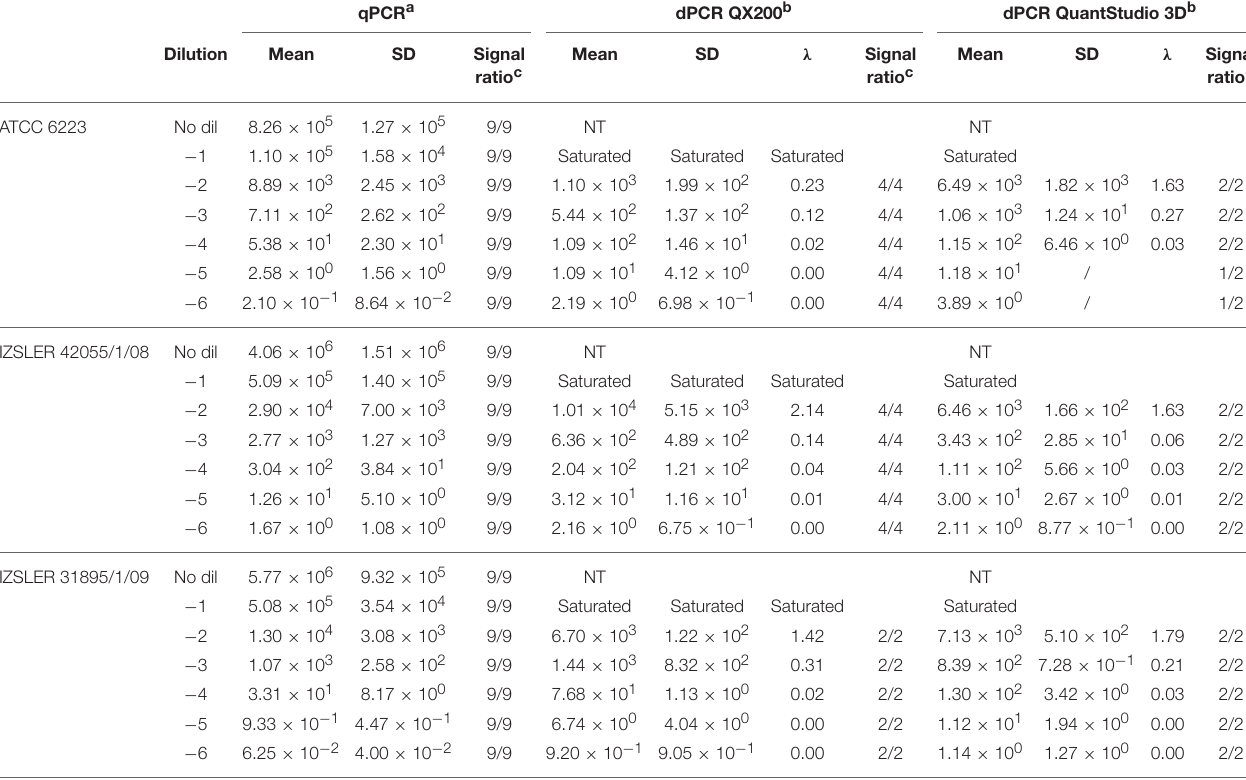
TABLE 4 | Experimental output of F. tularensis cells obtained by 23 kDa gene -qPCR, 23 kDa gene QX200-dPCR and 23 kDa gene-QuantStudio 3D